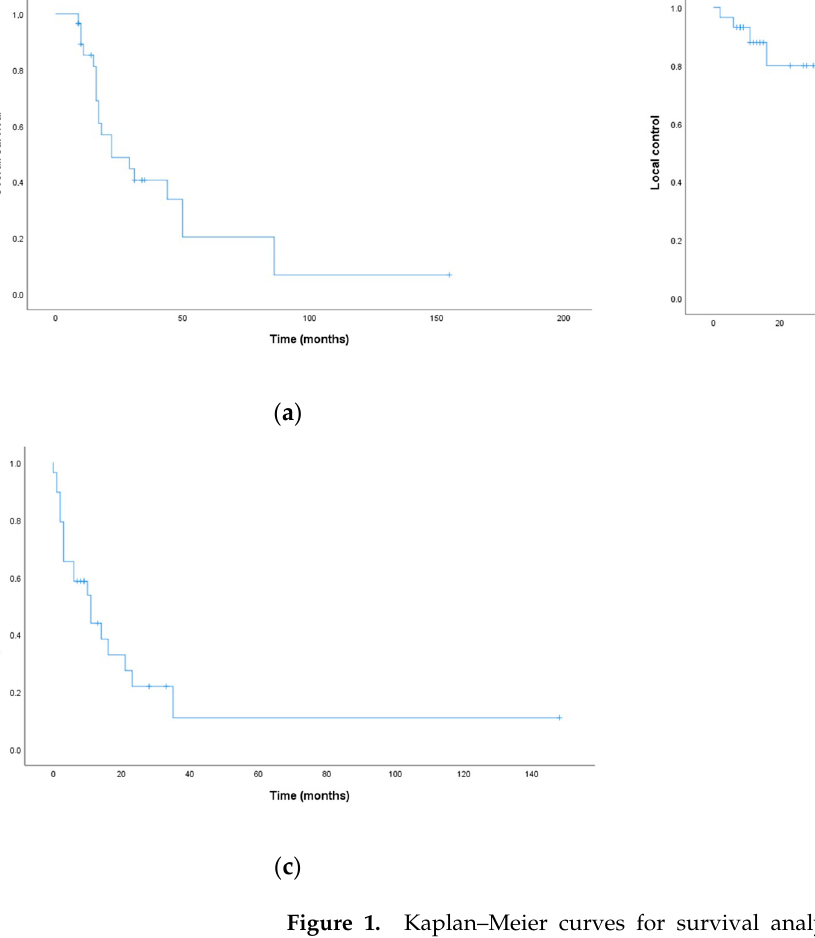
Figure 1. Kaplan–Meier curves for survival analysis: ( a ) overall survival; ( b ) local control; ( c ) progression-free survival. Table 4. Univariate analysis of survival by explicative